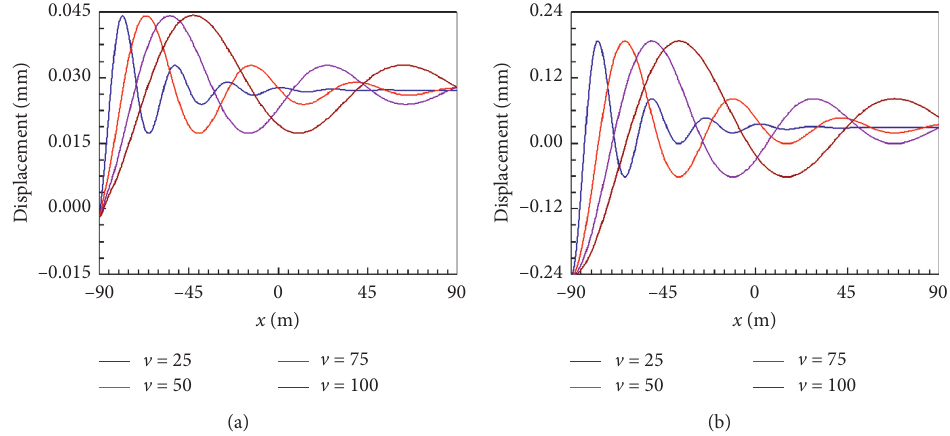
Figure 14: The history of vertical displacements corresponding with location of the moving vehicle: (a) bogie and (b) body.